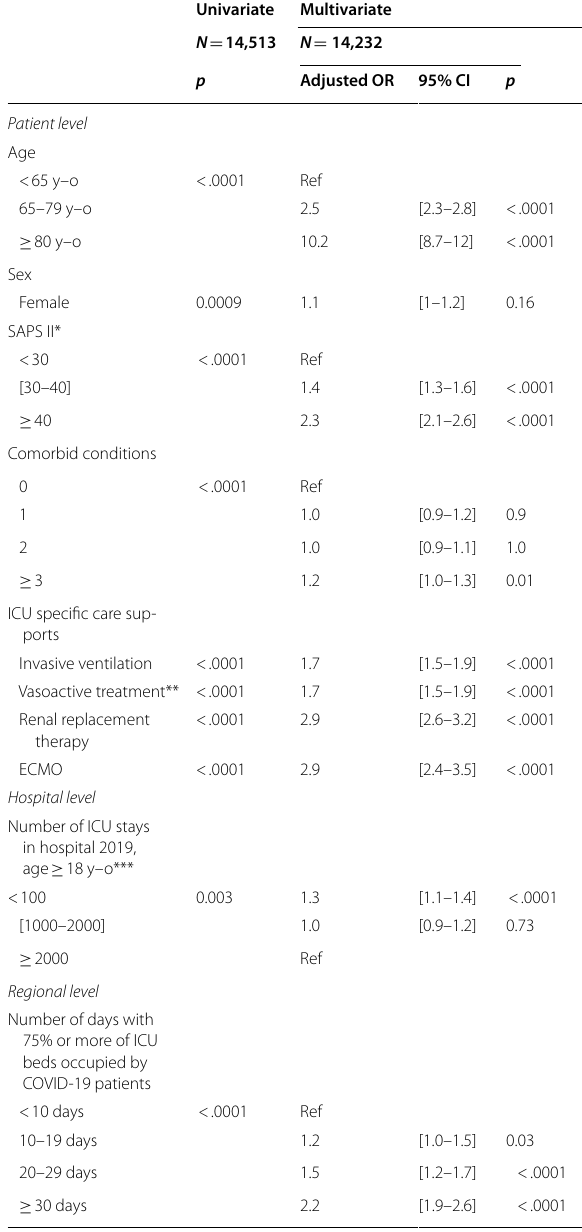
Table 2 Factors associated with case fatality in COVID‑19 patients admitted in the ICU in France, March, 1st to May,